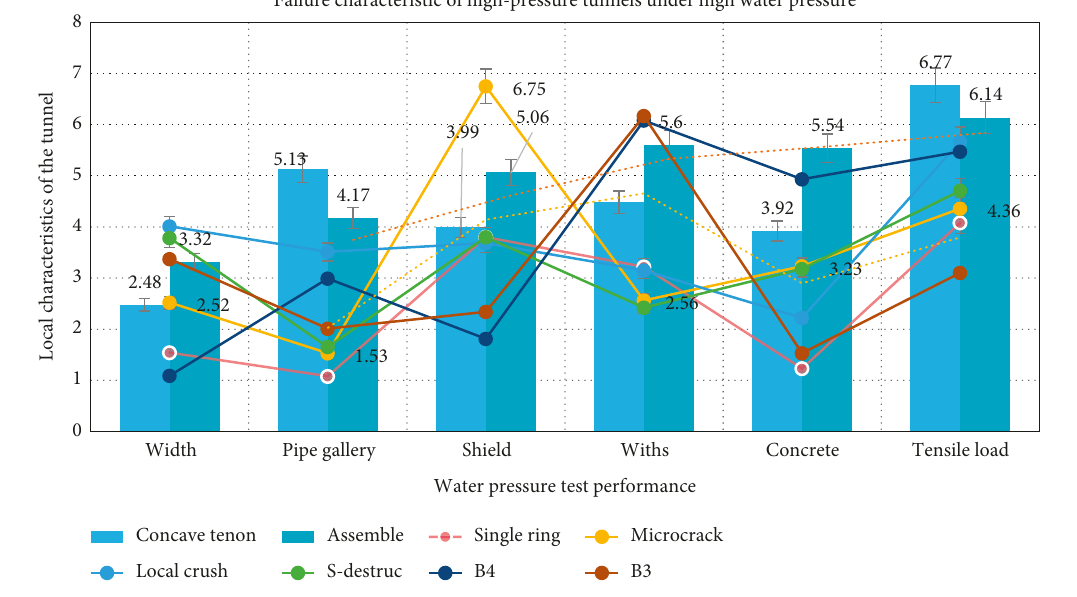
Figure 2: Failure characteristics of high-pressure tunnels under high water pressure. Table 2: The failure characteristics of the GIL composite pipe gallery under high water